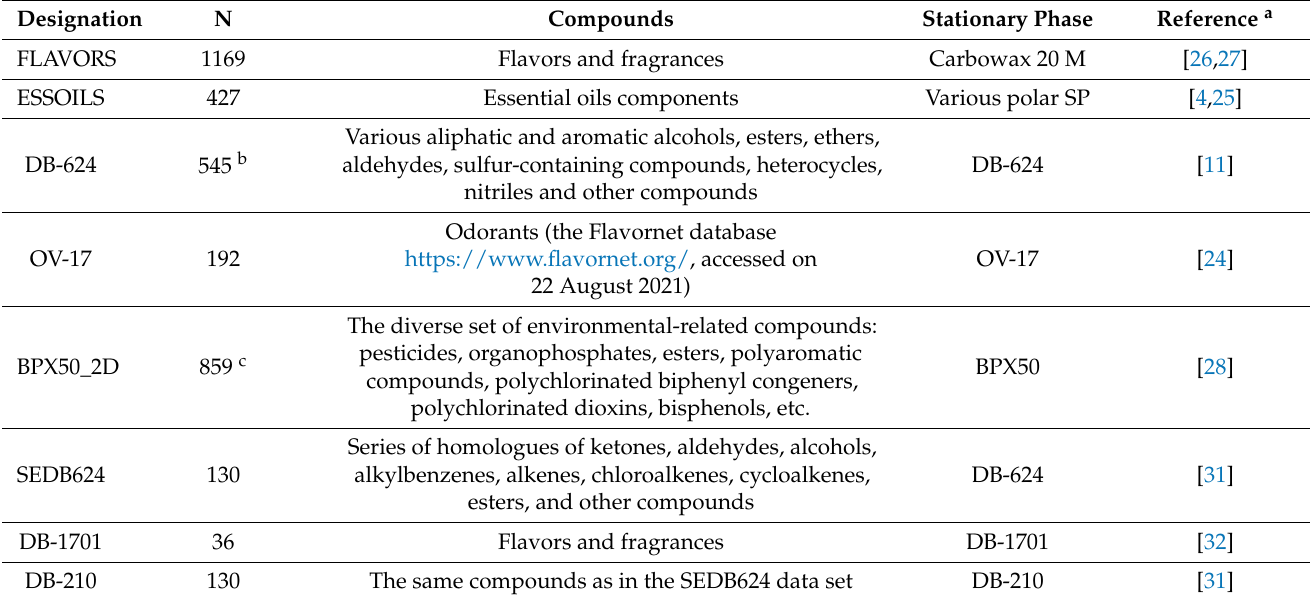
Table 1. The data sets considered in this work (except for the NIST 17